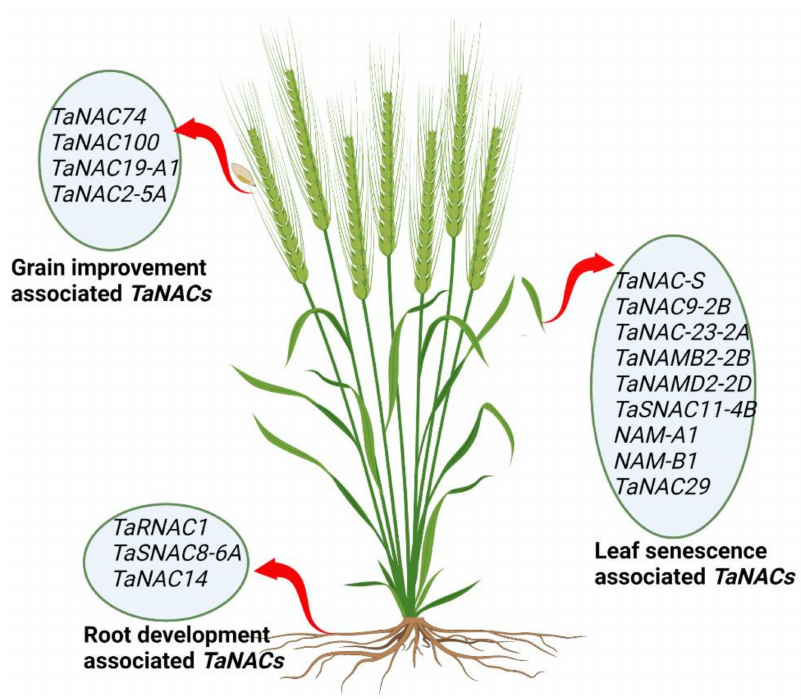
Figure 3. Pictorial representation of TaNACs associated with root development, grain improvement, and leaf senescence in the wheat